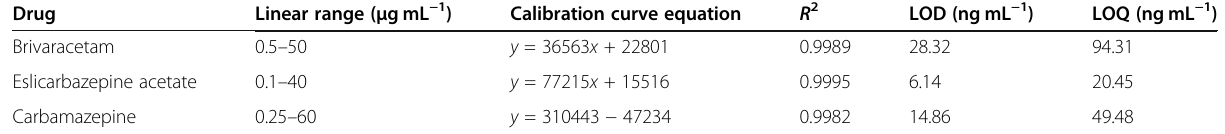
Table 1 Analytical parameters of the three antiepileptic drugs ’ quantitative analysis Drug